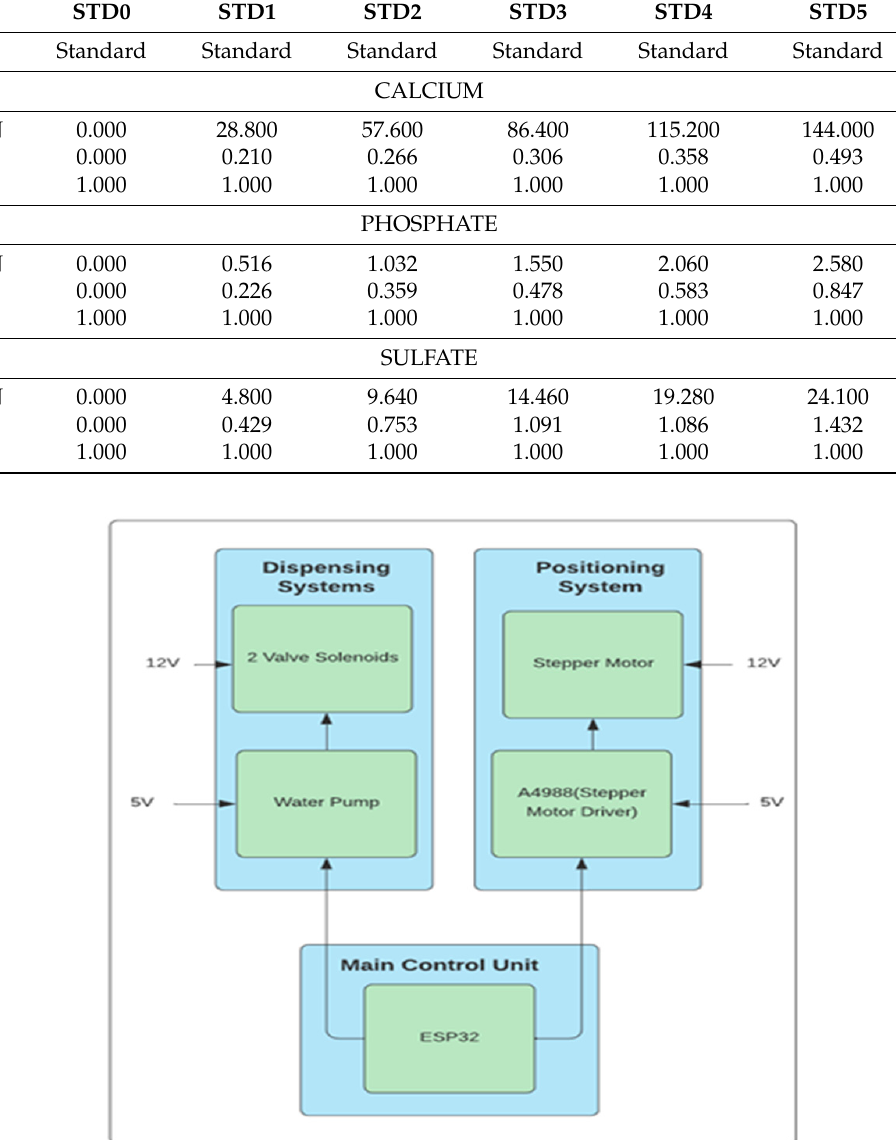
Figure 3. Schematic of the Positioning and Dispensing system of the NMS. In this system, each stage of the sequence was performed by one Nema 17 bipolar